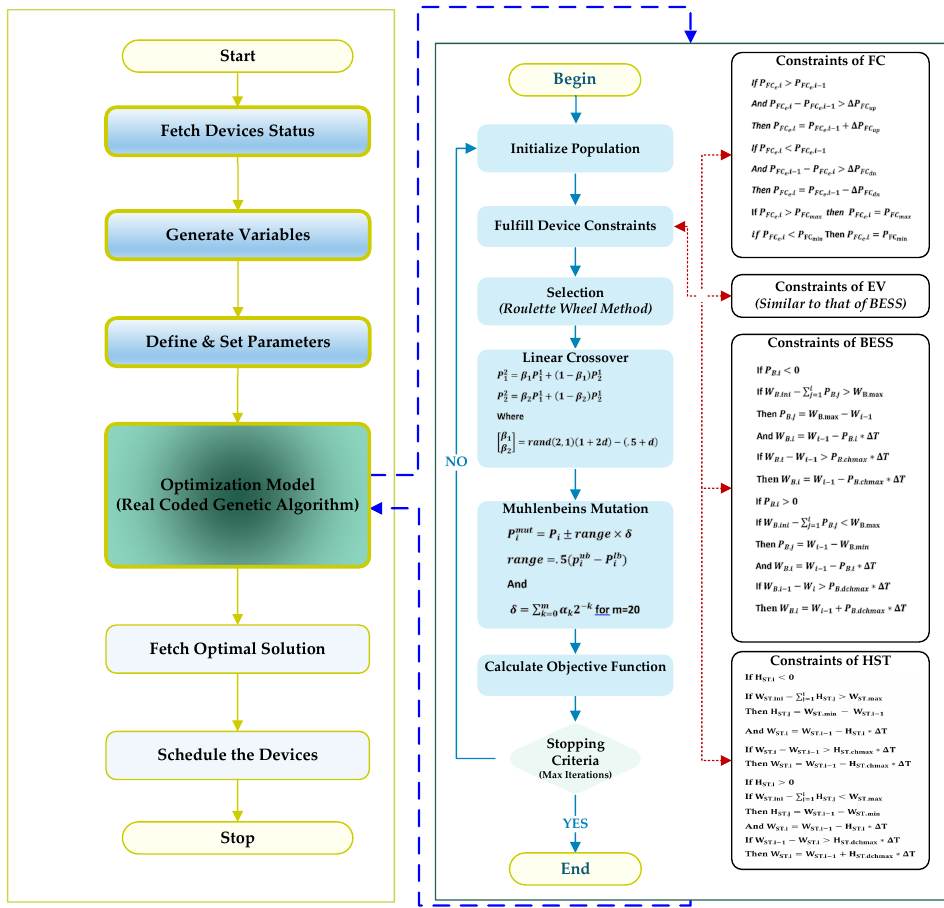
Figure 8. Proposed SBEM flow